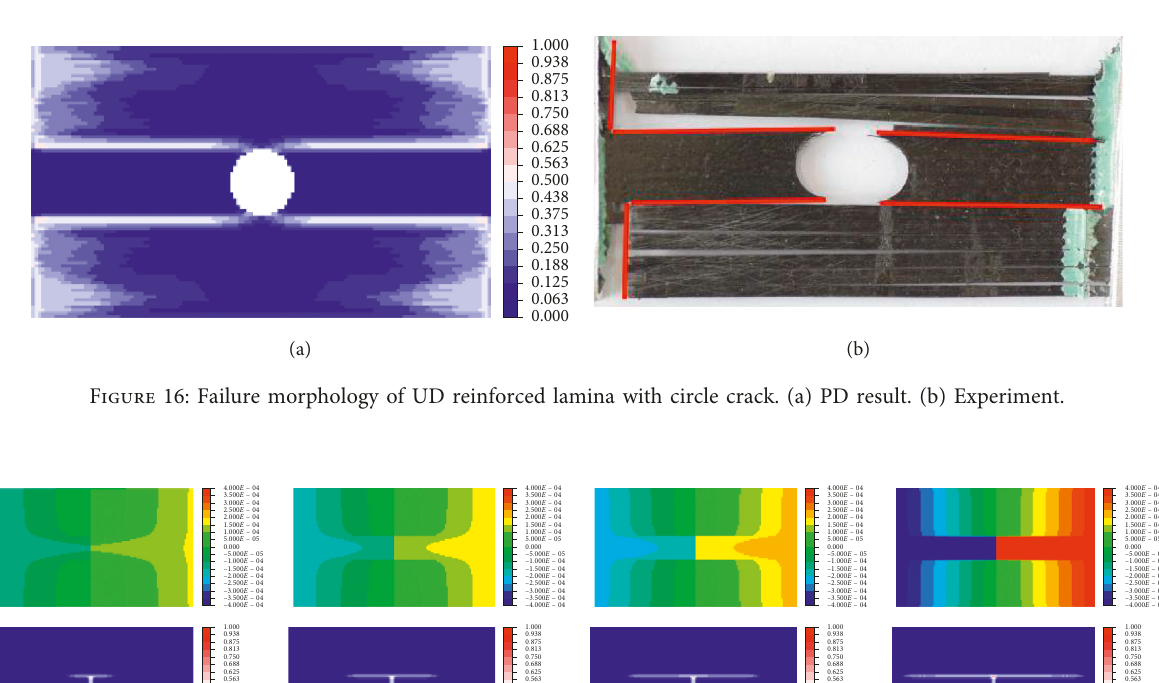
Figure 15: Final failure morphology of A-0 specimen with a hole under tension (damage (0-1)). (a) Matrix damage. (b) Fiber damage. (c) Total damage.